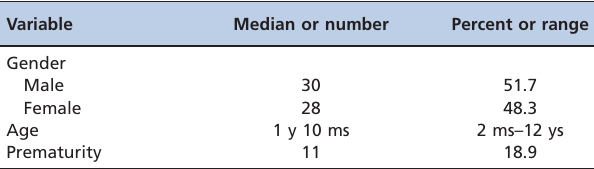
Number of patients (%)